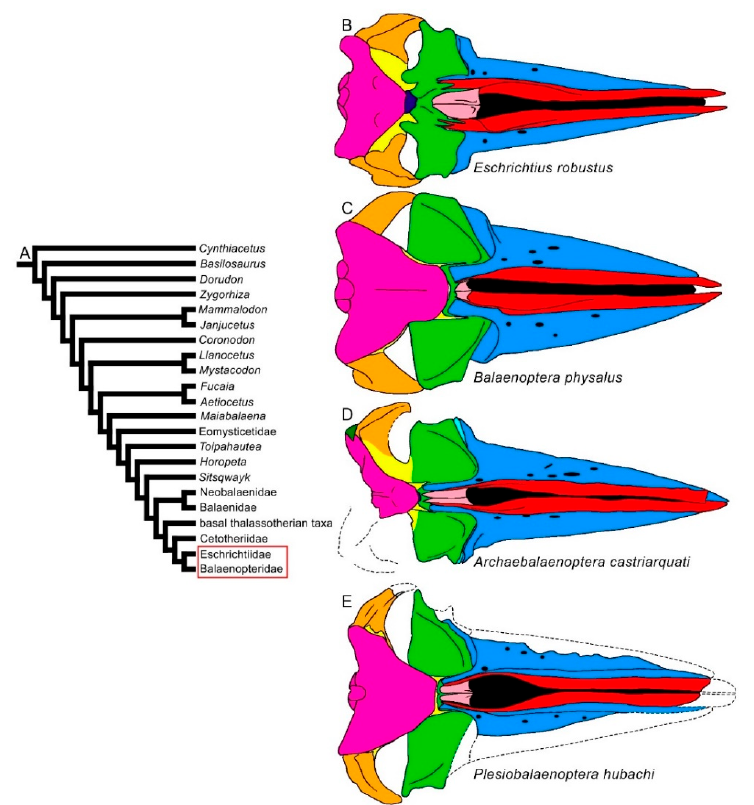
Figure 14. Diversity of balaenomorph mysticete skulls in dorsal view: Balaenopteroidea. ( A ) Phylogenetic relationships among mysticetes showing the position of Balaenopteroidea (Eschrichtiidae and Balaenopteridae). ( B ) Skull of Eschrichtius robustus . ( C ) Skull of Balaenoptera physalus . ( D ) Archebalaenoptera castriarquati . ( E ) Plesiobalaenoptera hubachi . Not to scale. The skulls are represented as if they shared the same condylobasal